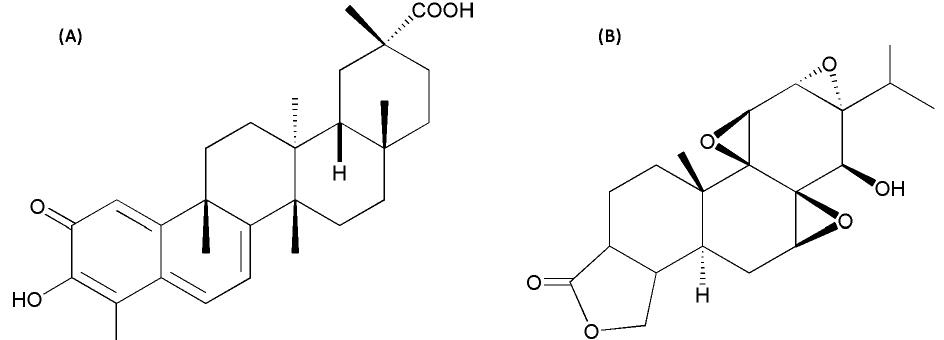
Figure 1. Chemical structure of two ingredients from Tripterygii wilfordii. ( A ) Celastrol, and ( B ) Figure1. Chemicalstructureof twoingredients from Tripterygiiwilfordii. ( A )Celastrol, and ( B ) triptolide.